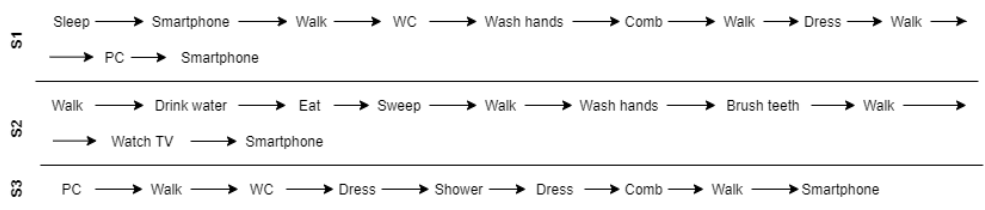
Figure 20. Fixed-Sequences of